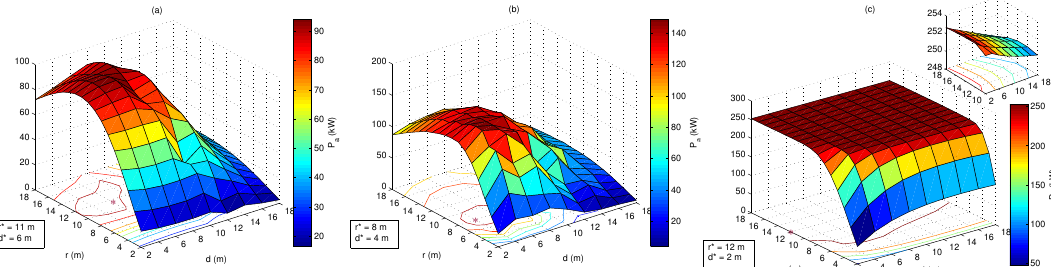
Figure 7. Absorbed power by the cylinders with oscillation amplitude constraints ( k C = 0.75) and without force constraints: ( a ) PC, ( b ) LC and ( c ) PSOC.